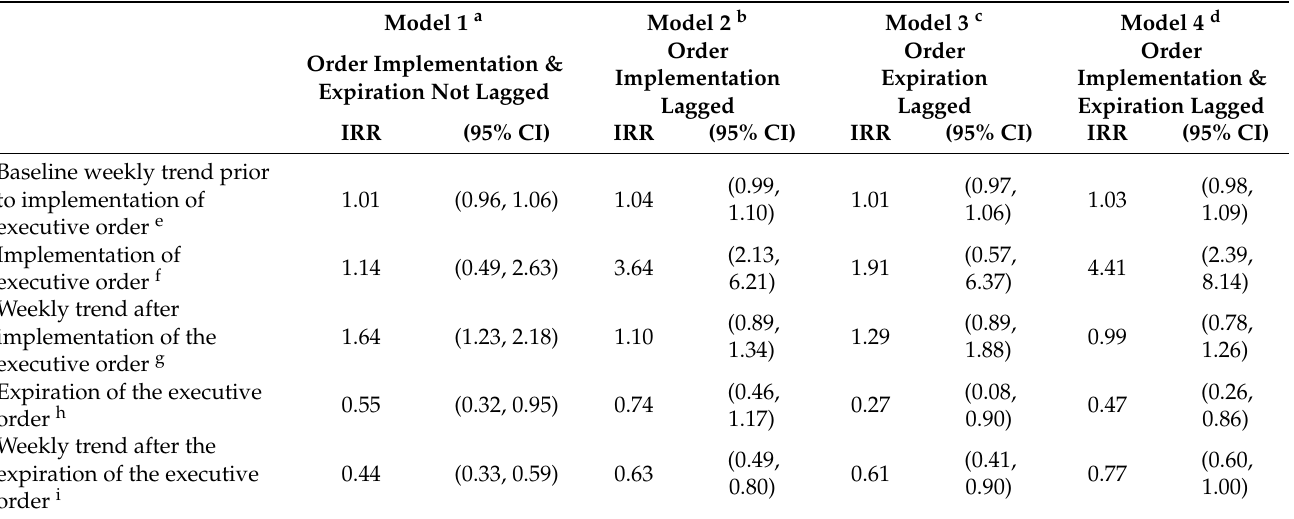
Table 2. Estimated change in number of out-of-state abortions among Texas residents, 1